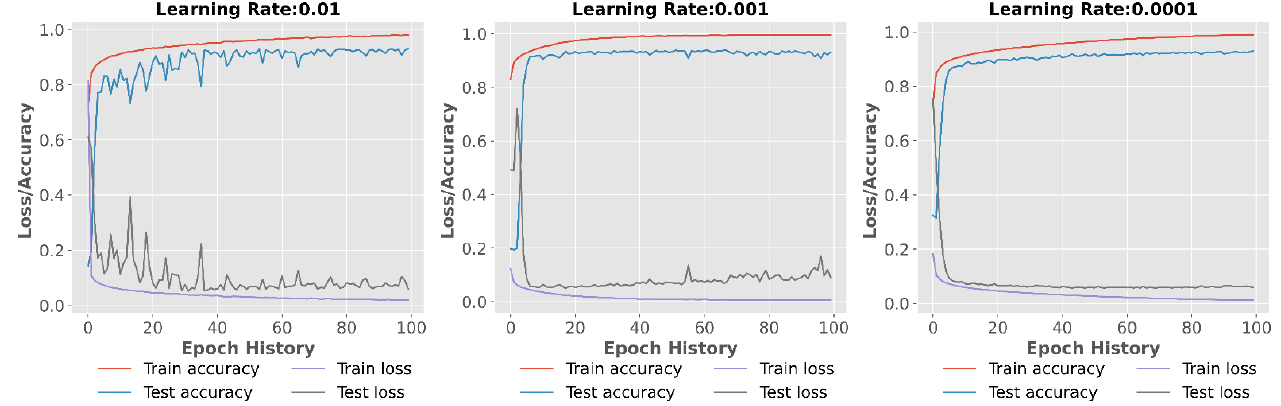
Figure 5. Classification accuracy of test set with training set learning rates of 0.01, 0.001, and 0.0001.